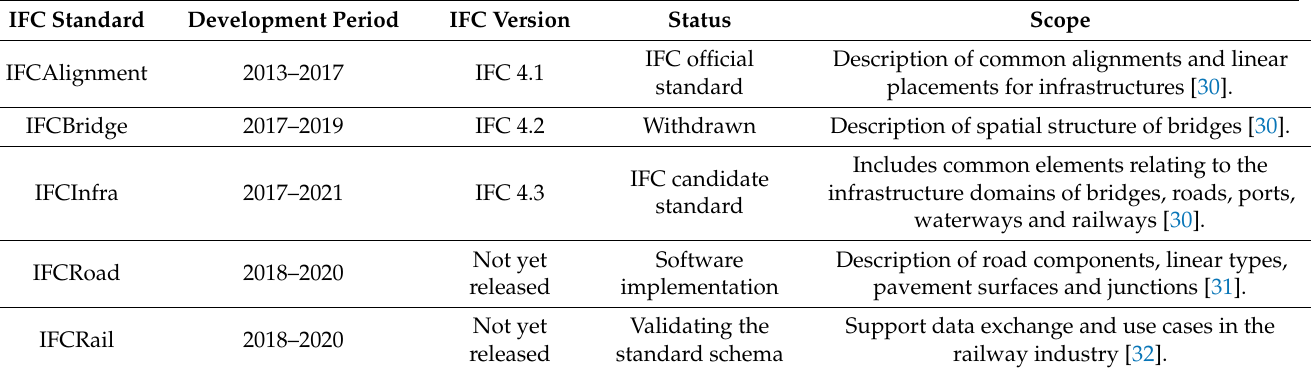
Table 1. Chronological development of some IFC standards for